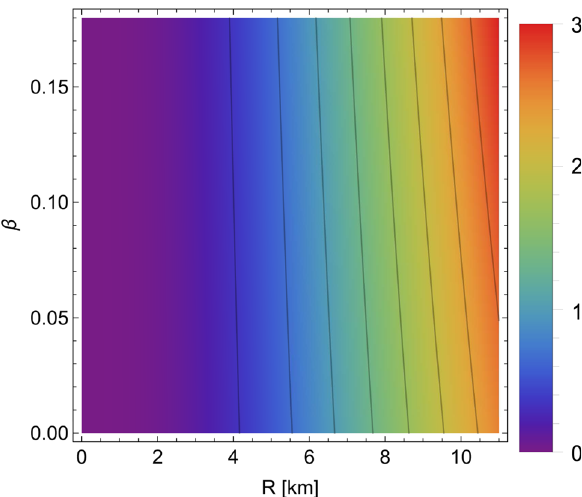
Fig. 10 The equi-mass contour diagram shows the mass distribution on R − β plane for C = 0 . 018 km